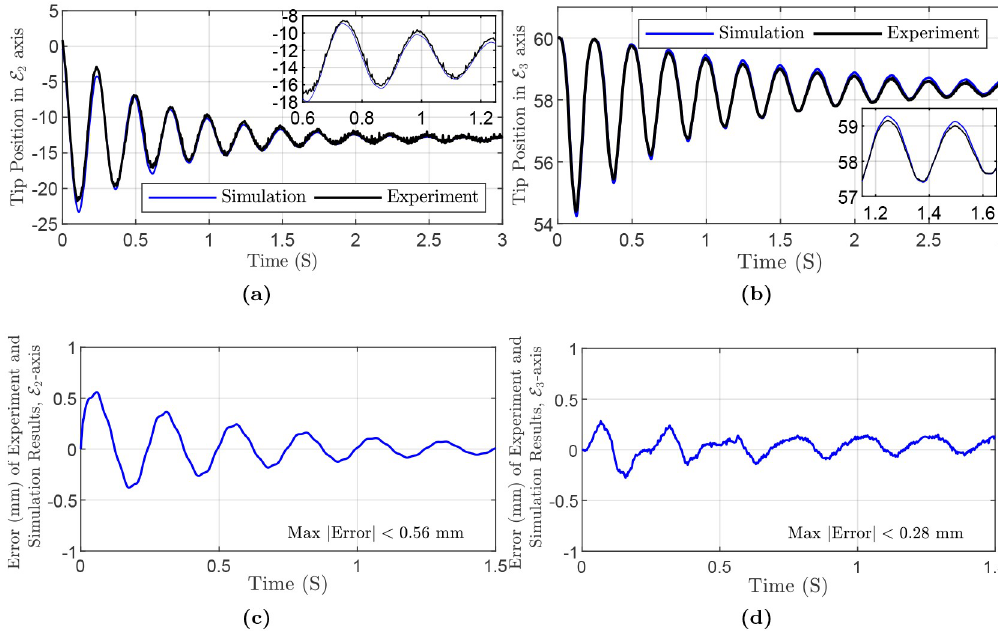
Fig 9. Simulation and experiment results of Polydimethylsiloxane (PDMS) rod, planar motion: (a) Tip Position in E direction. Inset magnifies the results in a small time range. (b) Tip Position in E (d) Error in E -axis direction. 3